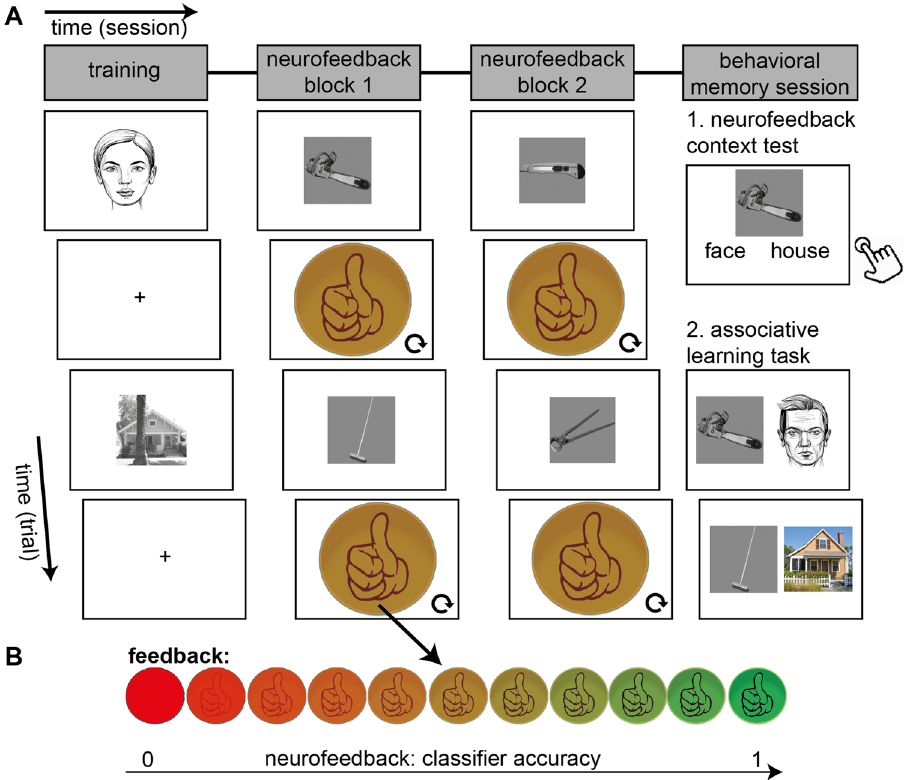
Figure 1. Structure of experimental sessions and neurofeedback. ( A ) Overview of the experiment. The experiment started with an MRI-session that included a training block, and two neurofeedback blocks. The training block contained pictures of faces and of houses, and was used to train a classifier on brain activity patterns evoked by faces and houses. During the two neurofeedback blocks, each trial (24 s duration) started with an image of an object (for 2 s), and was then followed by an abstract presentation of the face (one block) or house (the other block) classifier accuracy [see panel ( B )]. The MRI-session was followed by a behavioral memory session that included a neurofeedback context test in which memory was tested for the artificial context created by the neurofeedback. The neurofeedback context test was a two-alternative forced choice task during which the participants were presented with the same objects as during the neurofeedback blocks, and had to indicate for each object whether it belongs to faces or to houses (with a button press). Subsequently participants were presented with an associative learning task. During the associative learning task, each of the 32 objects from the neurofeedback blocks was associated with either a specific face or a specific house. Half of the objects were associated with a specific exemplar (face/house) of the same category as they received neurofeedback on in the MRI-session, and the other half of the objects were associated with a specific exemplar from the other category as they received neurofeedback on. After learning of these pairs, they filled in a Vividness of Visual Imagery Questionnaire, followed by a memory test. Here, it was tested for each object whether they remembered which category it was associated with, and subsequently, with which specific exemplar it was associated. ( B ) Neurofeedback. For each trial, the neurofeedback started with an orange circle in which a hand with a thumb up was presented. Based on the classifier accuracy, the alpha-level of the image was adapted, and could therefore change into a red circle (low classifier accuracy) or a green circle with a clearly visible thumb (high classifier accuracy). In one block, the classifier accuracy corresponded to the face category, and in the other block to the house category. The order of the two blocks were counterbalanced across